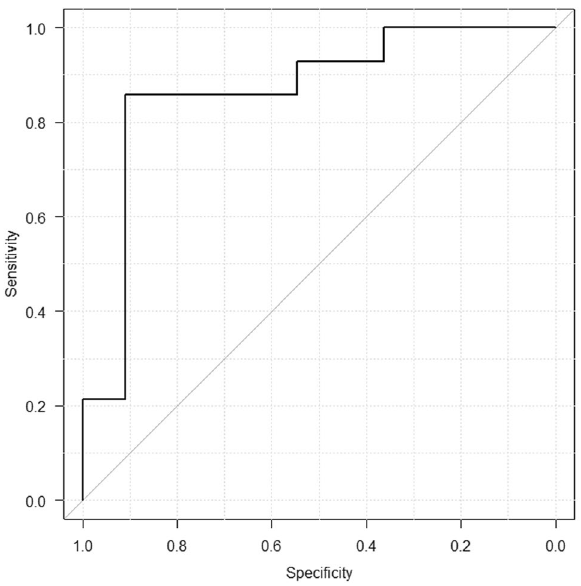
Figure 2. The Receiver Operating Characteristic (ROC) curve of the developed model: the area under curve (AUC) value was 0.864. The sensitivity and specificity of the best classification point (= 1.02 Gy) were 0.857 and 0.909,